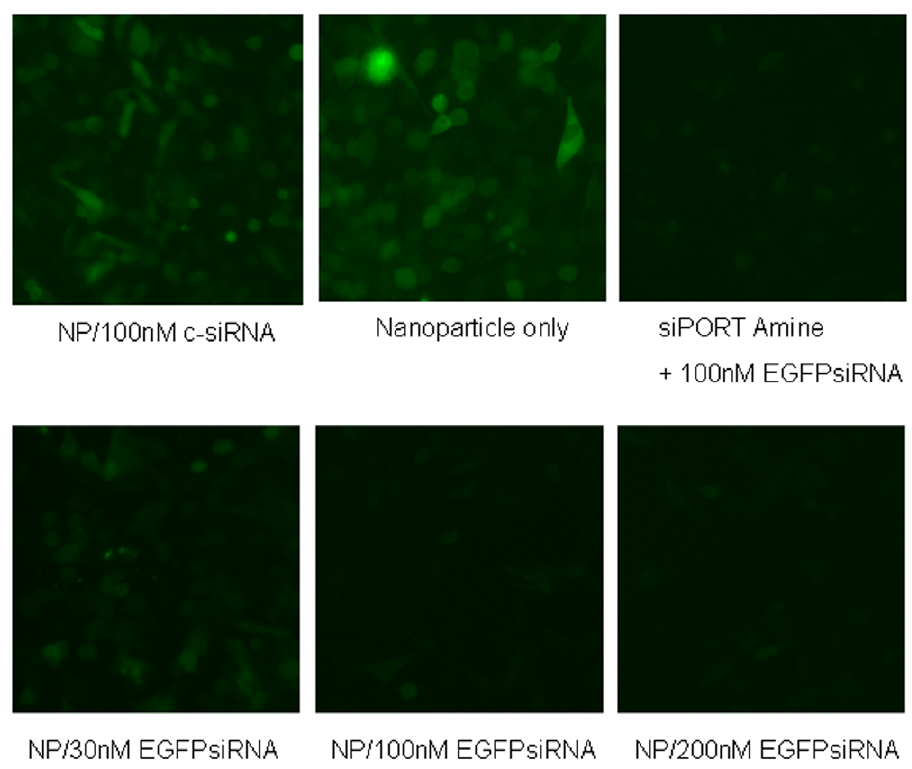
Figure 2. Effect of EGFP siRNA loaded nanoparticles on BHK-21-EGFP cells was assessed. EGFP siRNA was efficiently incorporated into cells and effectively inhibited the expression of EGFP in a dose dependent manner (NP: nanoparticle). siPORT TM NeoFX TM Transfection Agent (Ambion) was used as a positive control. Nanoparticles loaded with 100 nM non-specific siRNA (c-siRNA) and unloaded nanoparticles were used as negative controls.